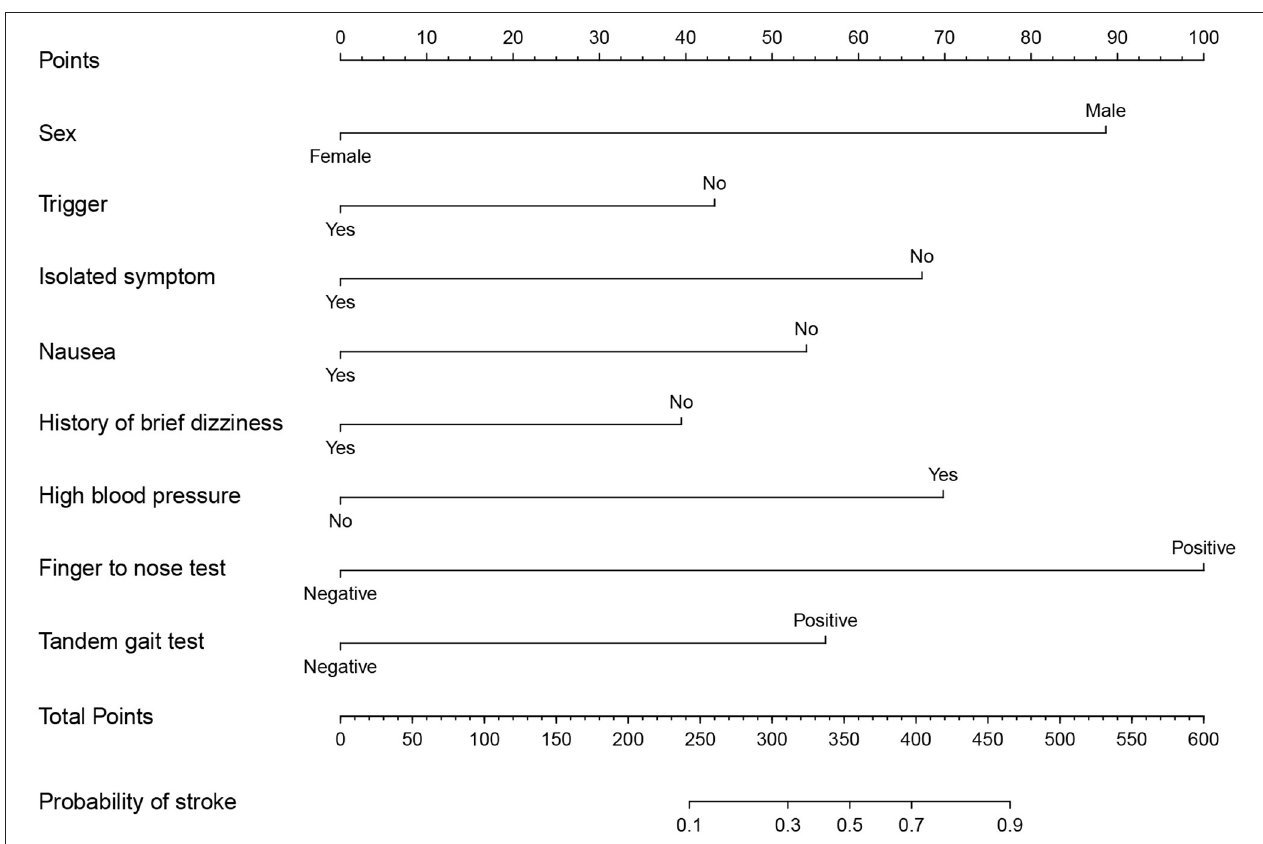
FIGURE 2 | Nomogram to determine the probability of stroke in dizziness/vertigo or imbalance. To use the nomogram, users should locate the sex of a patient on the Sex axis first, and then draw a line straight upward to the Points axis to determine the number of points received for his sex. Repeat this process for all axes of the variables, sum the points achieved for each predictor, and located this sum on Total Points axis. Finally, draw a line straight down from the Total Points axis to determine the Probability of stroke at the lower line of the